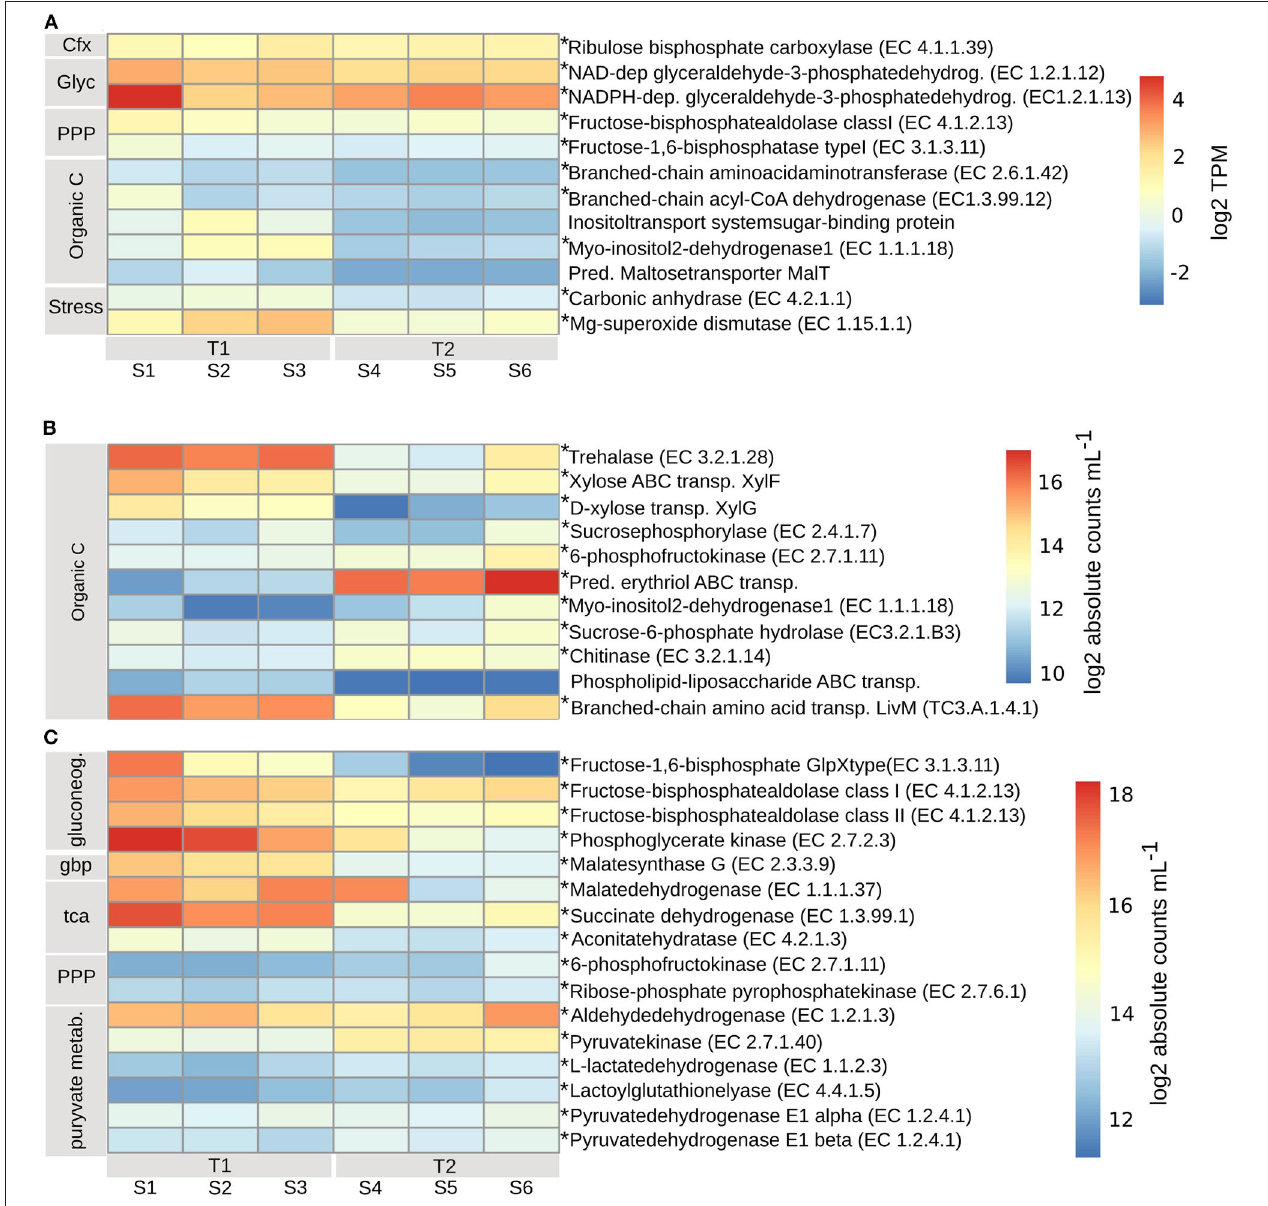
FIGURE 4 | Transcripts involved in inorganic and organic carbon uptake and assimilation for (A) planktonic eukaryotes (PE), transcripts per kilobase million (TPM) (grouped by SEED Rank3) log2 transformed. TPM values with standard errors (SE) can be found in Supplementary Table 4 . (B) bacterial (BAC) carbon uptake and utilization, (C) carbon cycling. Bacterial absolute transcript counts per mL (grouped by SEED Rank3), calculated according to formula in Satinsky et al. (2013) can be found in Supplementary Table 6 . To account for transcript length, counts were normalized to one mRNA standard at a time: pTZ19R (546nt), pFN19R (970nt) from which the mean was calculated (Beier et al., 2018), and then log2 transformed. Bacterial absolute transcript counts per mL (grouped by SEED Rank3), with standard errors (SE), calculated according to formula in Satinsky et al. (2013) can be found in Supplementary Table 6 . Asterisks indicate enzymes that significantly changed from T1 to T2 (adjusted p < 0.01). T1, first timepoint (samples S1–S3); T2, second timepoint (samples S4–S6); Cfx , carbon fixation; Glyc , glycolysis; PPP , pentose phosphate pathway; Organic C , organic carbon; Stress , response to nutrient stress; gluconeog , gluconeogenesis; gbp , glyoxylate bypass; tca , tca cycle; pyruvate metab , pyruvate metabolism.